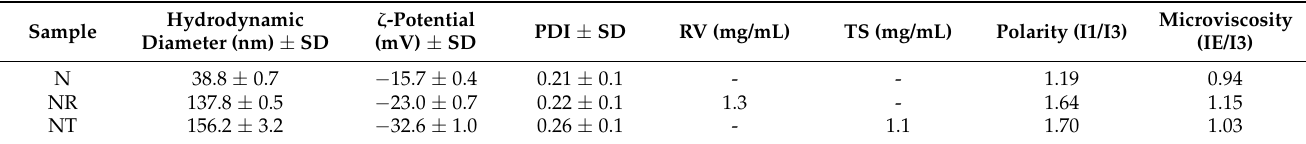
Table 2. Chemical physical features of all samples.